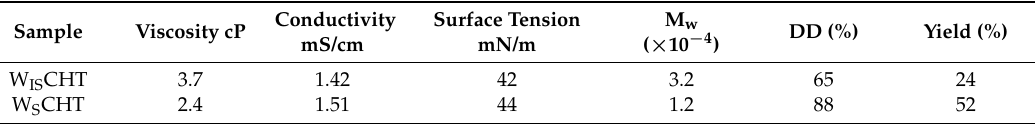
Table 1. Properties of raw and final product.